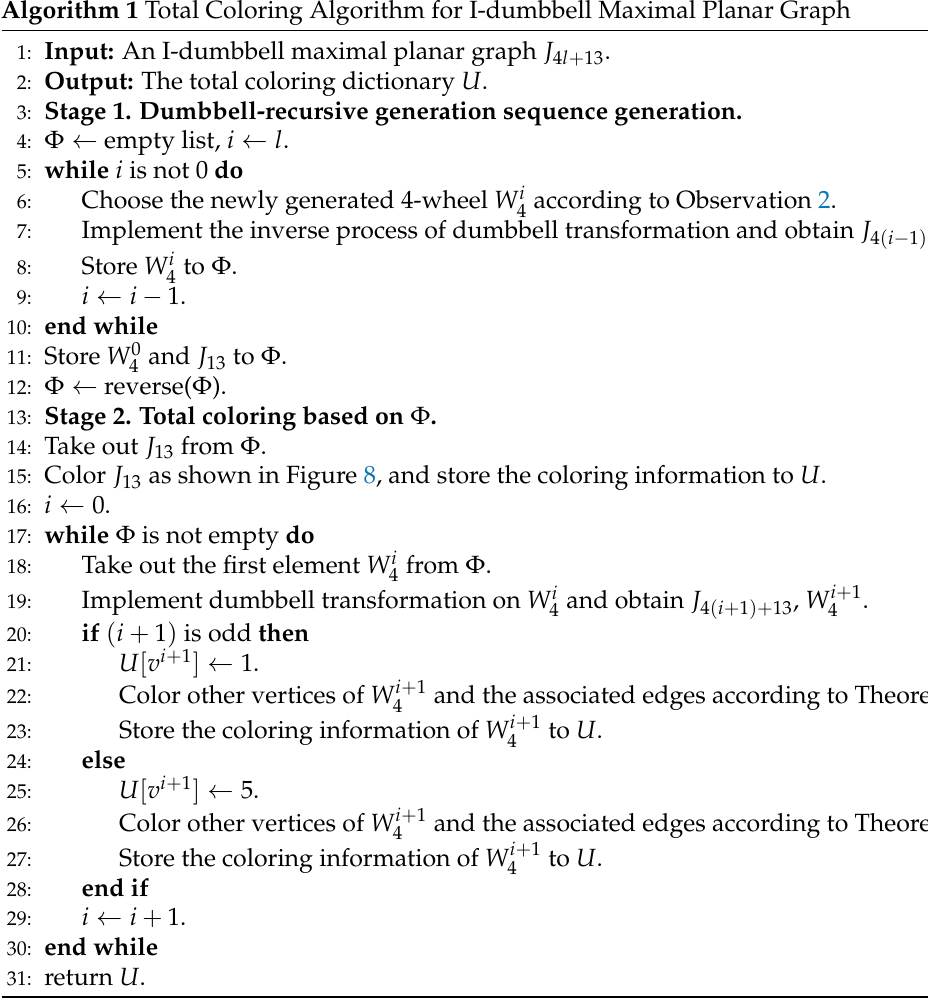
Algorithm 1 Total Coloring Algorithm for I-dumbbell Maximal Planar